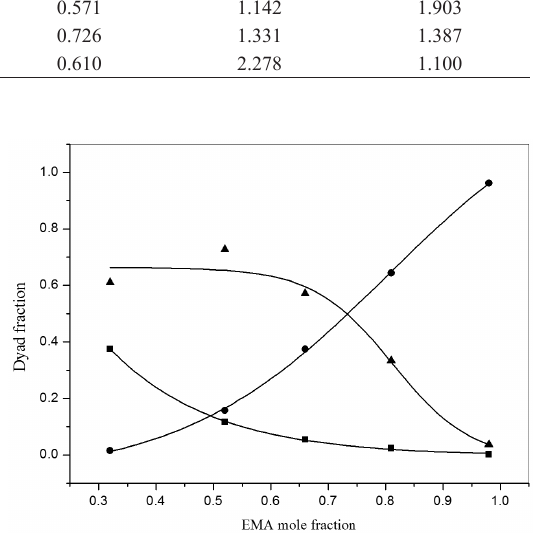
Figure 6. Dyad monomer sequence fractions versus EMA moles fraction for the CMA-CMA (■), EMA-EMA (●) and CMA-EMA (▲) dyads.